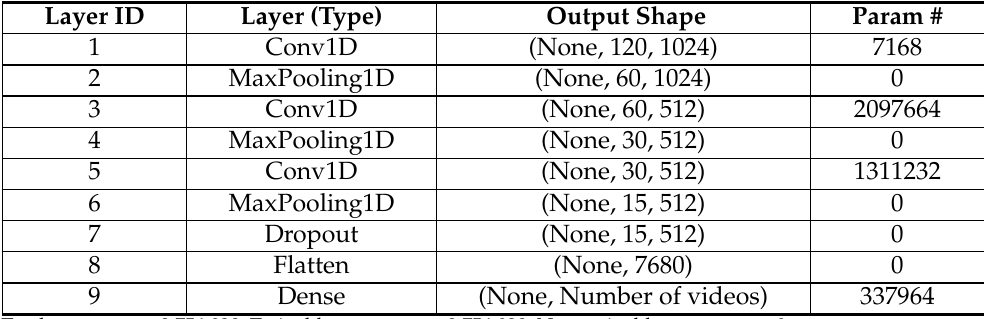
Table 1. Summary of the BPS